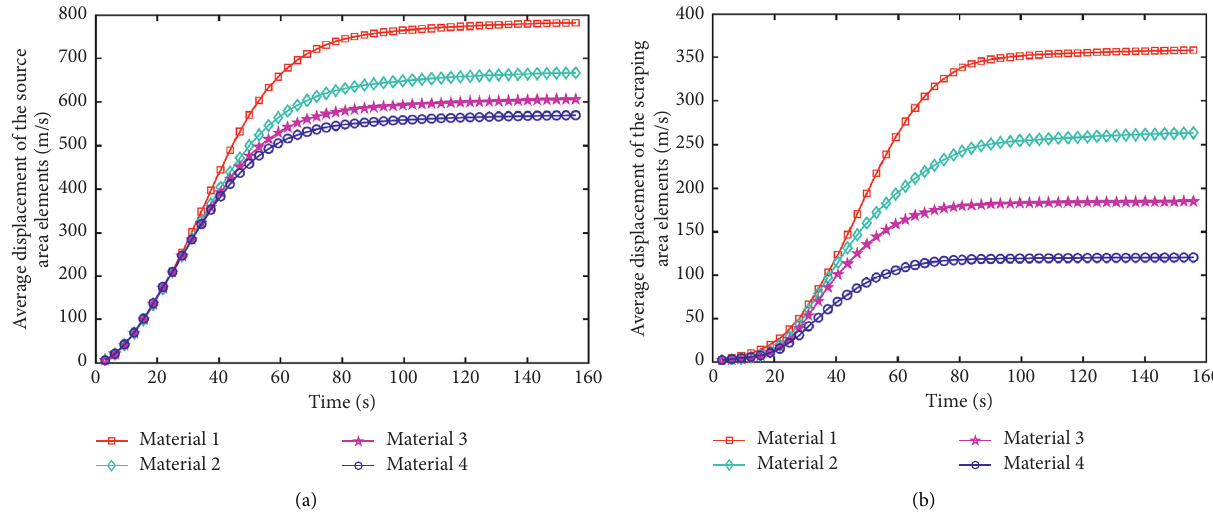
Figure 13: The average displacement of the (a) source area and (b) scraping area elements of four materials with different strength.